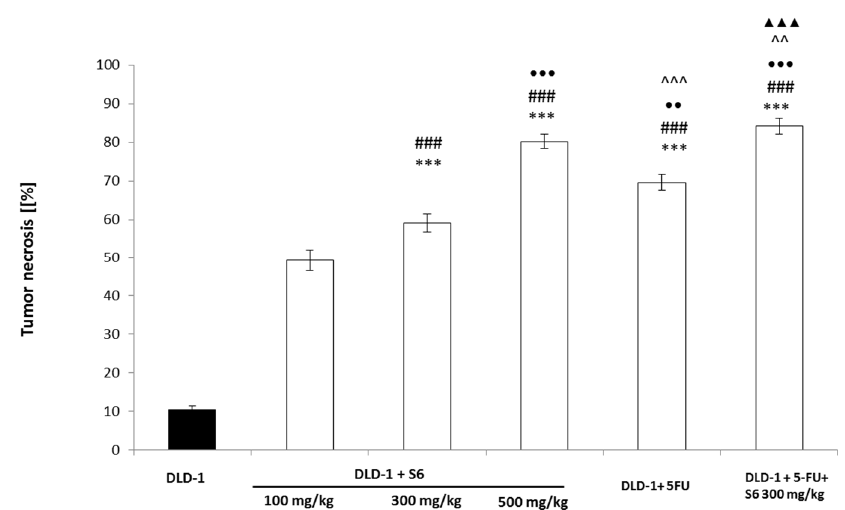
Figure 5. Tumor necrosis in induced CRC tumors from experimental groups. The results are expressed as the mean ± SEM for each group. *** p < 0.001 compared with the DLD-1 group; ### p < 0.001 compared with the DLD-1 + S6 100 mg/kg; •• p < 0.01 and ••• p < 0.001 compared with the DLD-1 + S6 300 mg/kg group; ^^ p < 0, 01 and ^^^ p < 0.001 compared with the DLD-1 + S6 500 mg/kg group; ▲▲▲ p < 0.001 compared with the DLD + 5-FU.